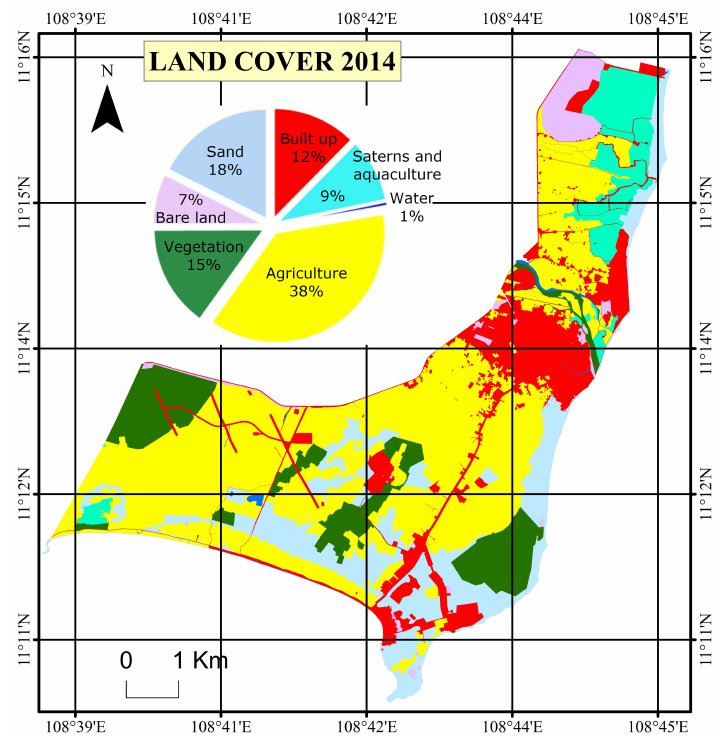
Figure A1. The governmental map of land use in the study area in